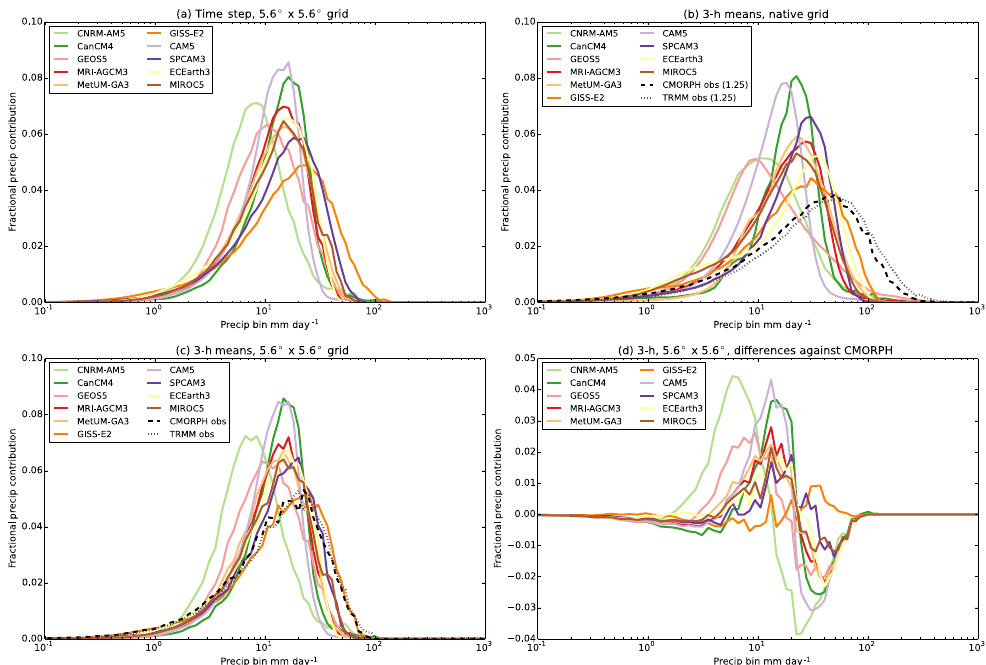
Figure 13. As in Fig. 8, but for (a) time step precipitation rates averaged to a 5.6 ◦ × 5 . 6 ◦ grid, and (b–d) : 3h precipitation rates on (b) the native horizontal grid and (c, d) averaged to a 5.6 ◦ × 5.6 ◦ grid. Panel (d) shows differences for each model minus CMORPH, using the 5.6 ◦ × 5.6 ◦ data. Panel (b) is repeated from Fig. 8 for ease of